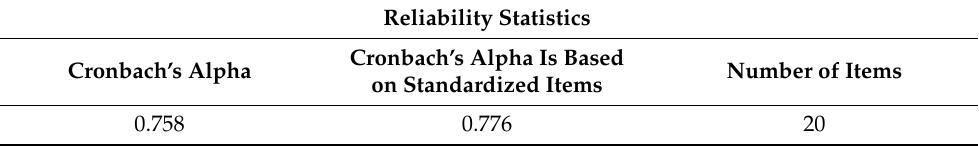
Table 3. Cronbach’s alpha